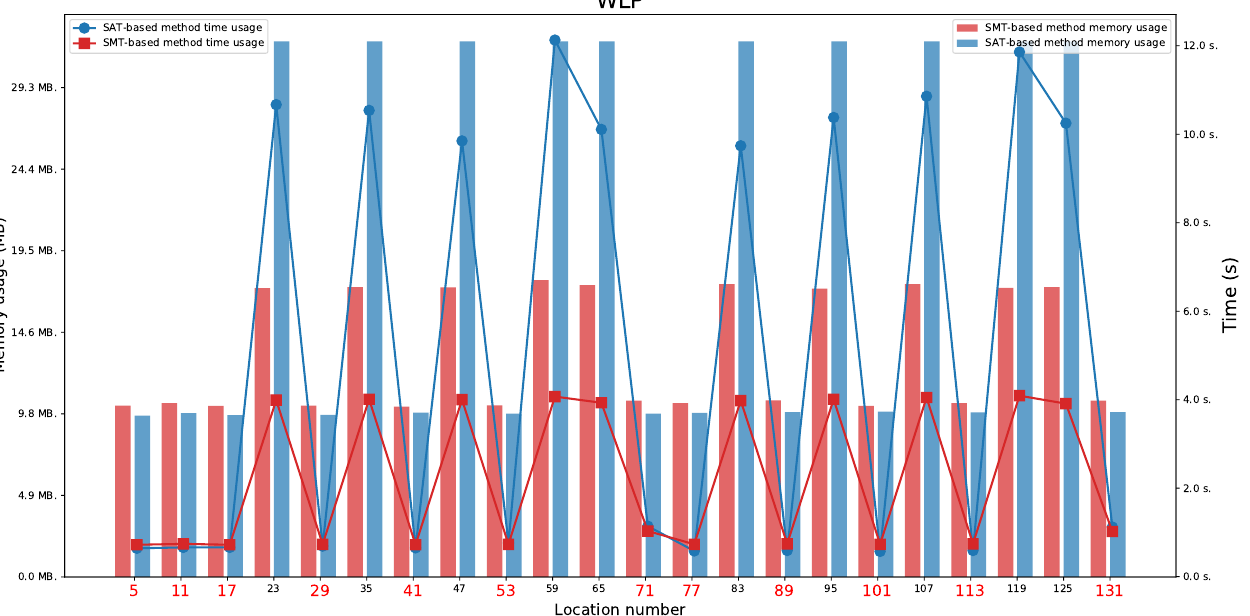
Figure 10. The WLP: Time and memory usage for checking the last locations’ reachability in each execution automaton for both lifetime values equal to 10. The reachable states are marked in